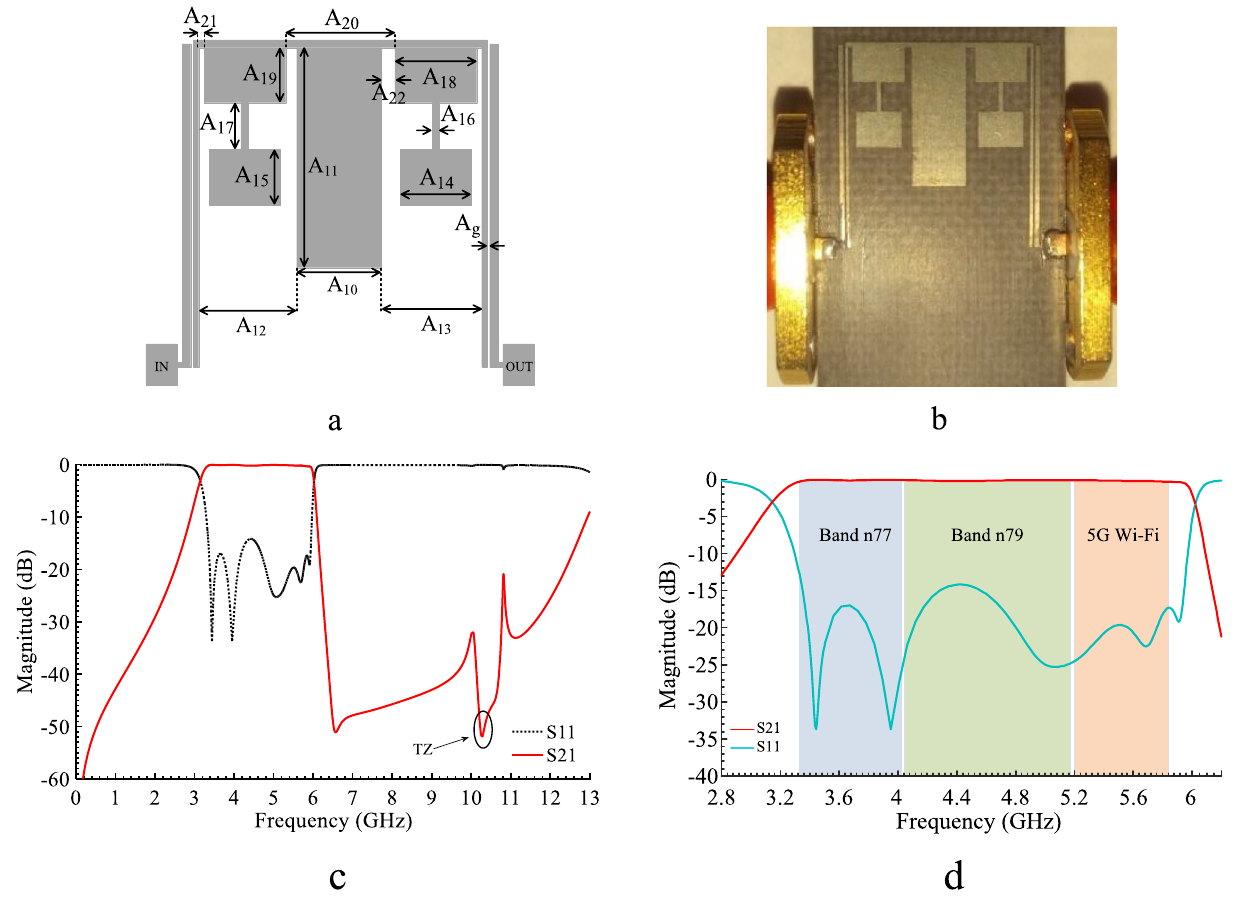
Figure 7. Proposed BPF: ( a ) Layout ( b ) prototype, ( c ) EM simulation result ( d ) Pass-band range EM